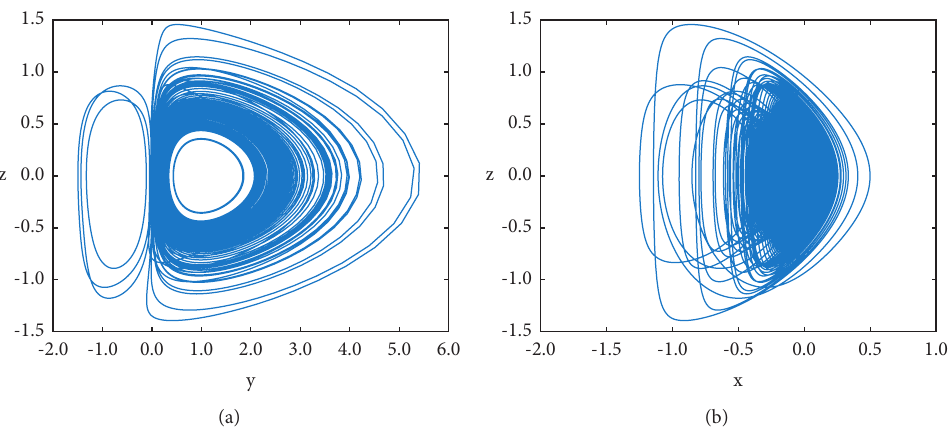
Figure 1: Chaotic phase diagram of System (1) with (a) � 5, (b) � 3, and x ( 0 ) � [ 0 00 ] T [9].